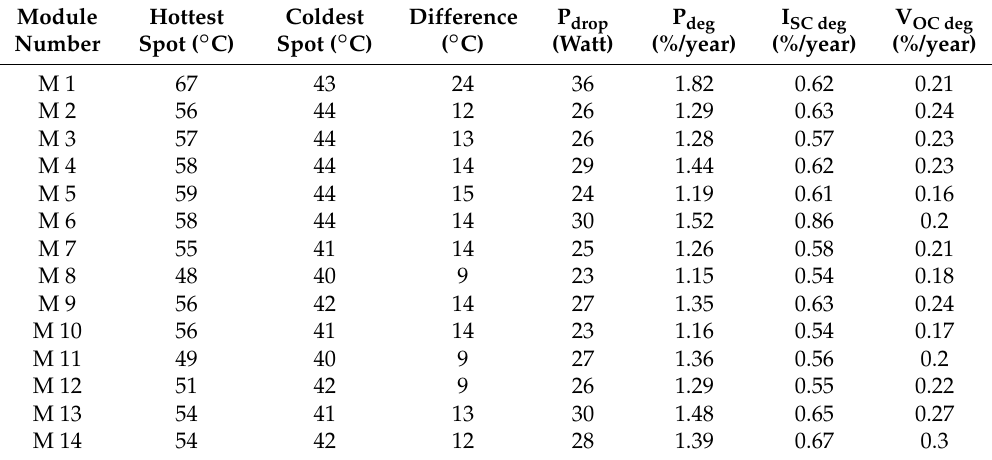
Table 4. Hot spot test results and degradation